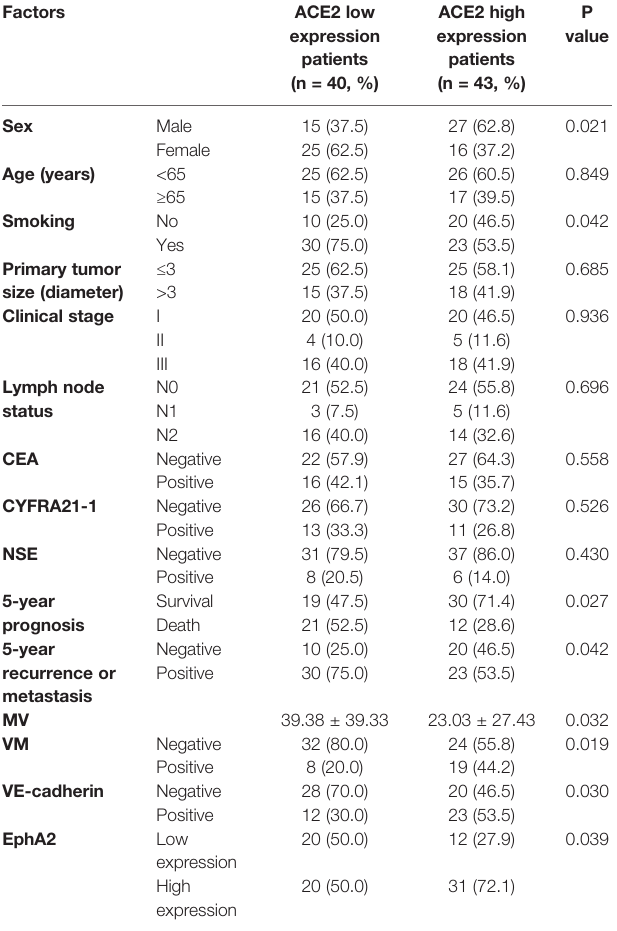
TABLE 2 | The relativity between ACE2 expression and clinicopathological characteristics in NSCLC patients. Factors ACE2 low